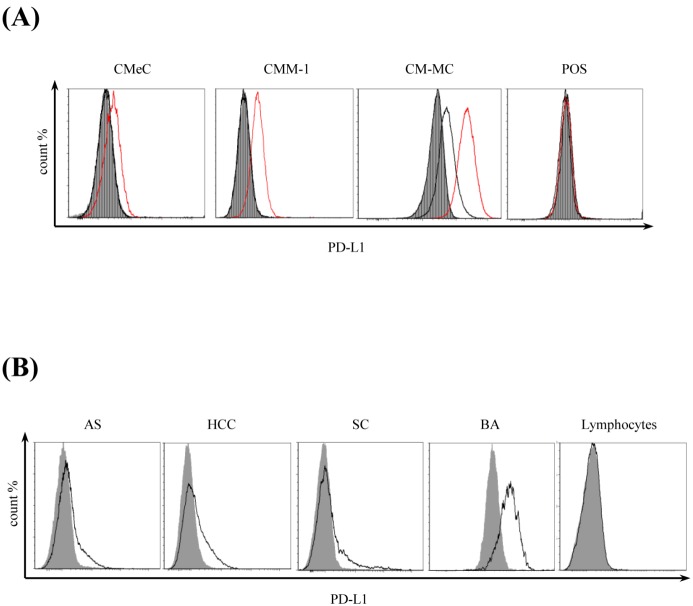
Expression of PD-L1 on dog tumor cells.(A) Representative data for the analysis of PD-L1 expression on dog tumor cell lines (Table 3). Cells maintained in the medium or those stimulated by IFN-γ (100 ng/mL) for 24 h were stained with anti-PD-L1 monoclonal antibody 4G12-C1 or isotype control antibody (rat IgG2a). Black line, medium/4G12-C1; red line, IFN-γ/4G12-C1; shaded area, medium/isotype control; vertical-striped area, IFN-γ/isotype control. (B) Tumor tissues excised surgically from clinical cases of dog tumors were treated with collagenase, and a tumor single cell suspension was obtained. To reduce the effect of collagenase on the degradation of PD-L1 and to restore the cell surface PD-L1, the tumor cells were cultured in the medium for 24 h before FACS analysis. Lymphocytes obtained from healthy dogs were used as a negative control to confirm that the collagenase and culture treatment would not upregulate the PD-L1 expression. The histogram shows the expression of PD-L1 on each tumor cell. Solid line, 4G12-C1; shaded area, isotype control. AS, angiosarcoma; HCC, hepatocellular carcinoma; SC, squamous carcinoma; and BA, breast adenocarcinoma. Details of each tumor samples are shown in Table 4.